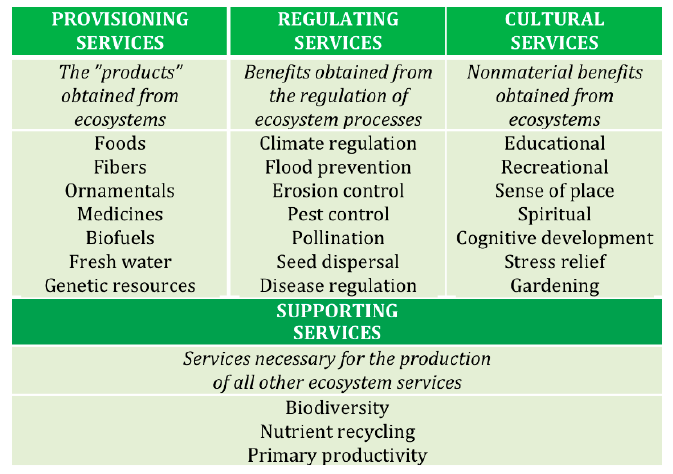
Figure 2. Ecosystem services from urban greenspaces. These include provisioning services, regulating services, cultural services, and supporting services. Source: Millennium Ecosystem Assessment. Ecosystems and Human Well-Being. Reprinted from Colding and Barthel [56].